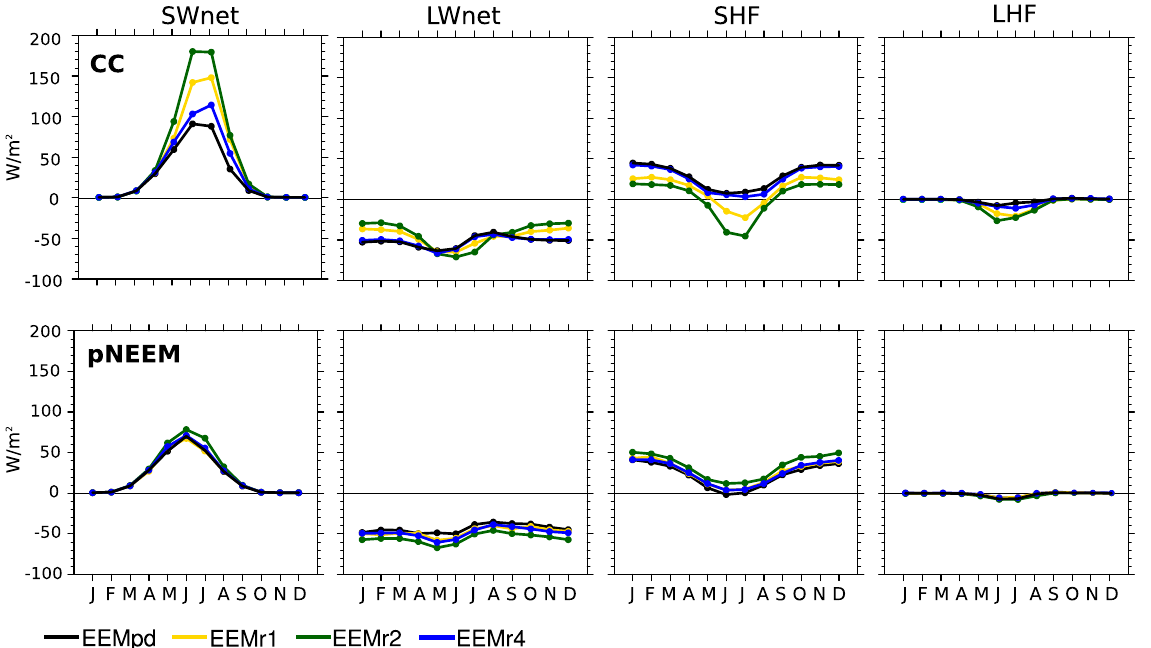
Figure 8. Annual cycle of surface heat fluxes (Wm − 2 ) at Camp Century (CC, top) and pNEEM (bottom). The sign convention is positive into the surface. Note that EEMr3 is not shown as it is basically the same as EEMr2 as these two simulations include the same GrIS topography and surface conditions at CC and